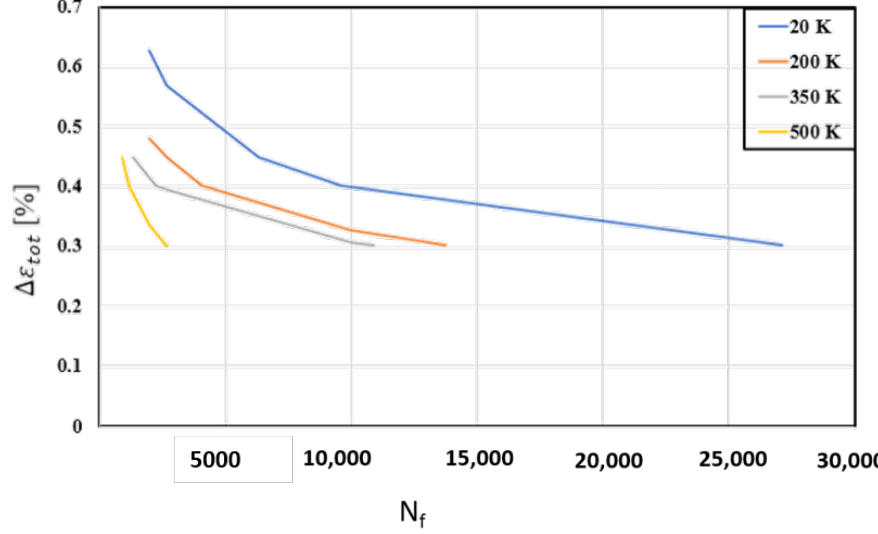
Figure 11. Strain range vs. number of cycles to failure [16].